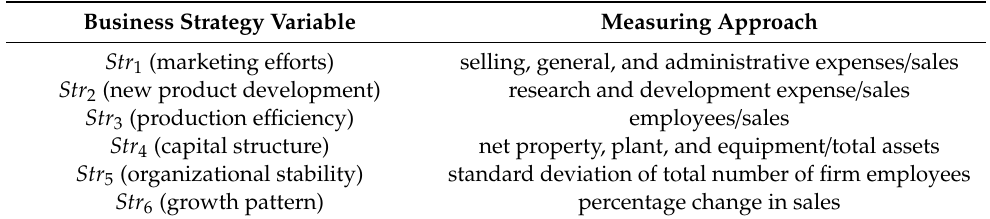
Table 1. Approach to measuring business strategies